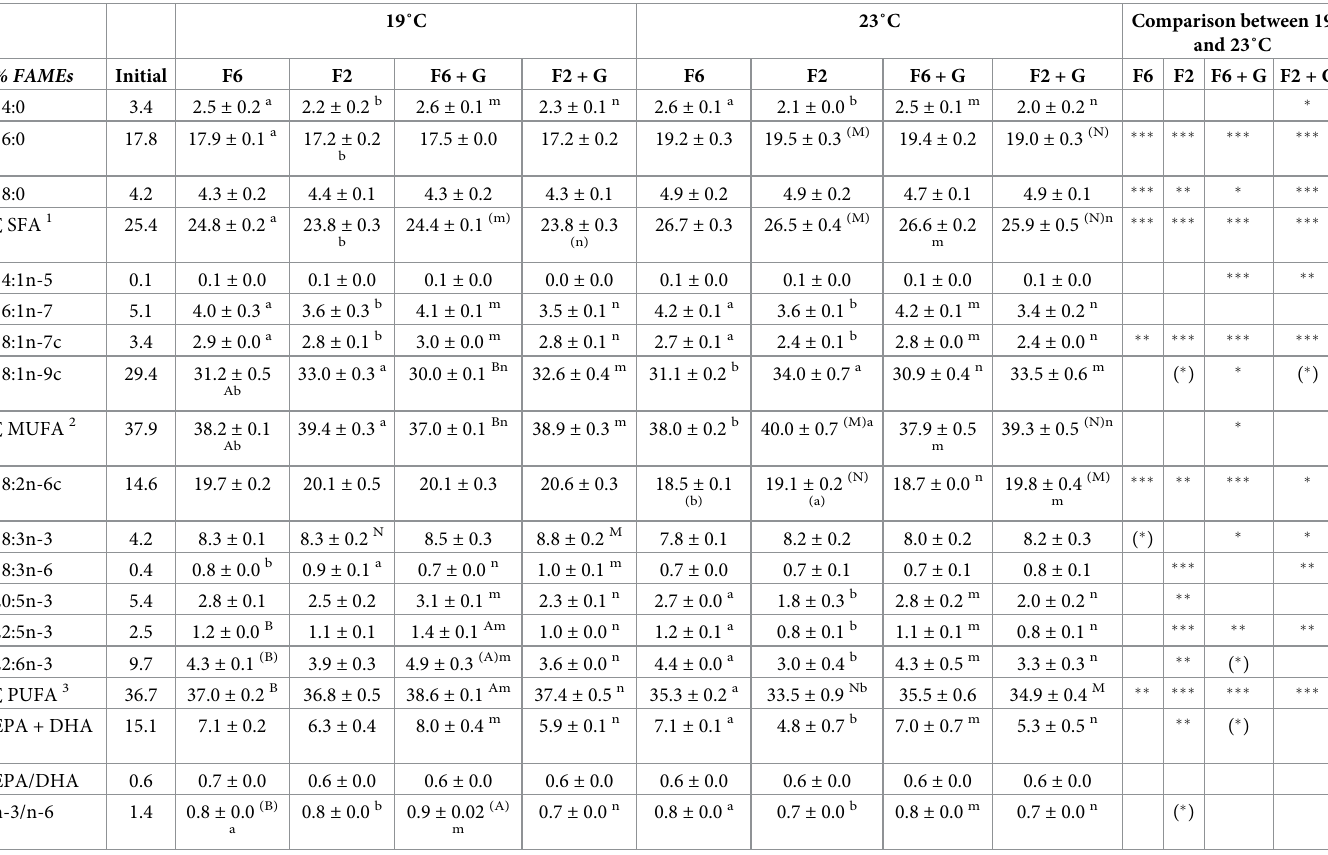
Table 7. Fatty acid composition (percentage of total fatty acid methyl esters (% FAMEs)) of fillet tissue of gilthead sea bream at the end of the 8 week feeding trial held at two different temperatures (19˚C and 23˚C). F6 and F2 indicate the feeding with the control diets containing 6% and 2% DM fish oil, respectively. +G indicates feeding diets supplemented with 0.15% DM genistein. 19˚C 23˚C Comparison between 19 and